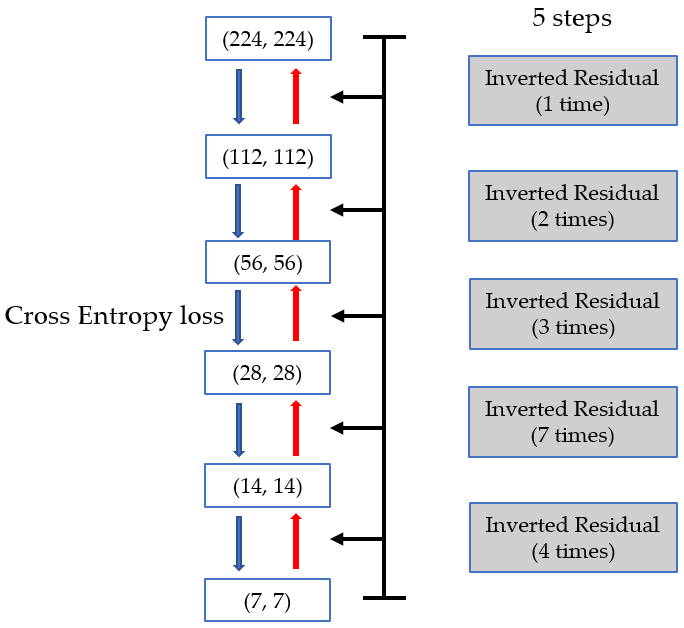
Figure 7. Proposed Mobile-Unet architecture. Table 1. Contraction processing of our Mobile-Unet.